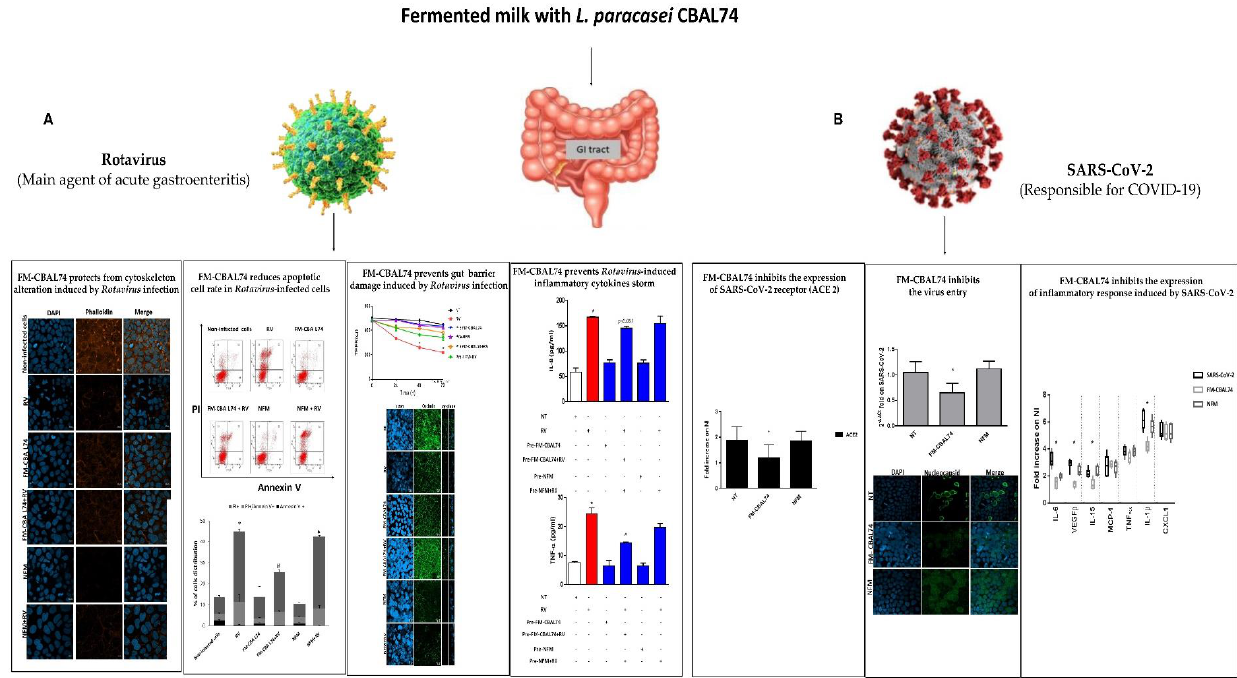
Figure 5. Protective action of FM-CBAL74 against viral infections in human enterocytes . ( Panel A ): FM-CBAL74 elicited beneficial effects on the gut barrier integrity preventing an RV-induced decrease in transepithelial electrical resistance and up-regulating the tight junction protein occludin, and reducing the RV- induced increase in IL-8 and TNF- α production in Caco -2 cells [12]. ( Panel B ): FM-CBAL74 was able to significantly reduce the number of infected enterocytes, as demonstrated by the reduction of nucleocapsid viral protein (N) positive cells, and to down-regulated ACE2 expression, preventing SARS-CoV-2 entry into human enterocytes. Furthermore, FM-CBAL74 was able to prevent the cytokine storm, inhibiting the IL- 1β, IL6, vascular endothelial growth factor B, and IL -15 production induced by SARS-CoV-2 [13]. The symbol * means p < 0.05.